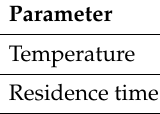
Table 4. Slow pyrolysis conditions adopted for the experiment. Parameter